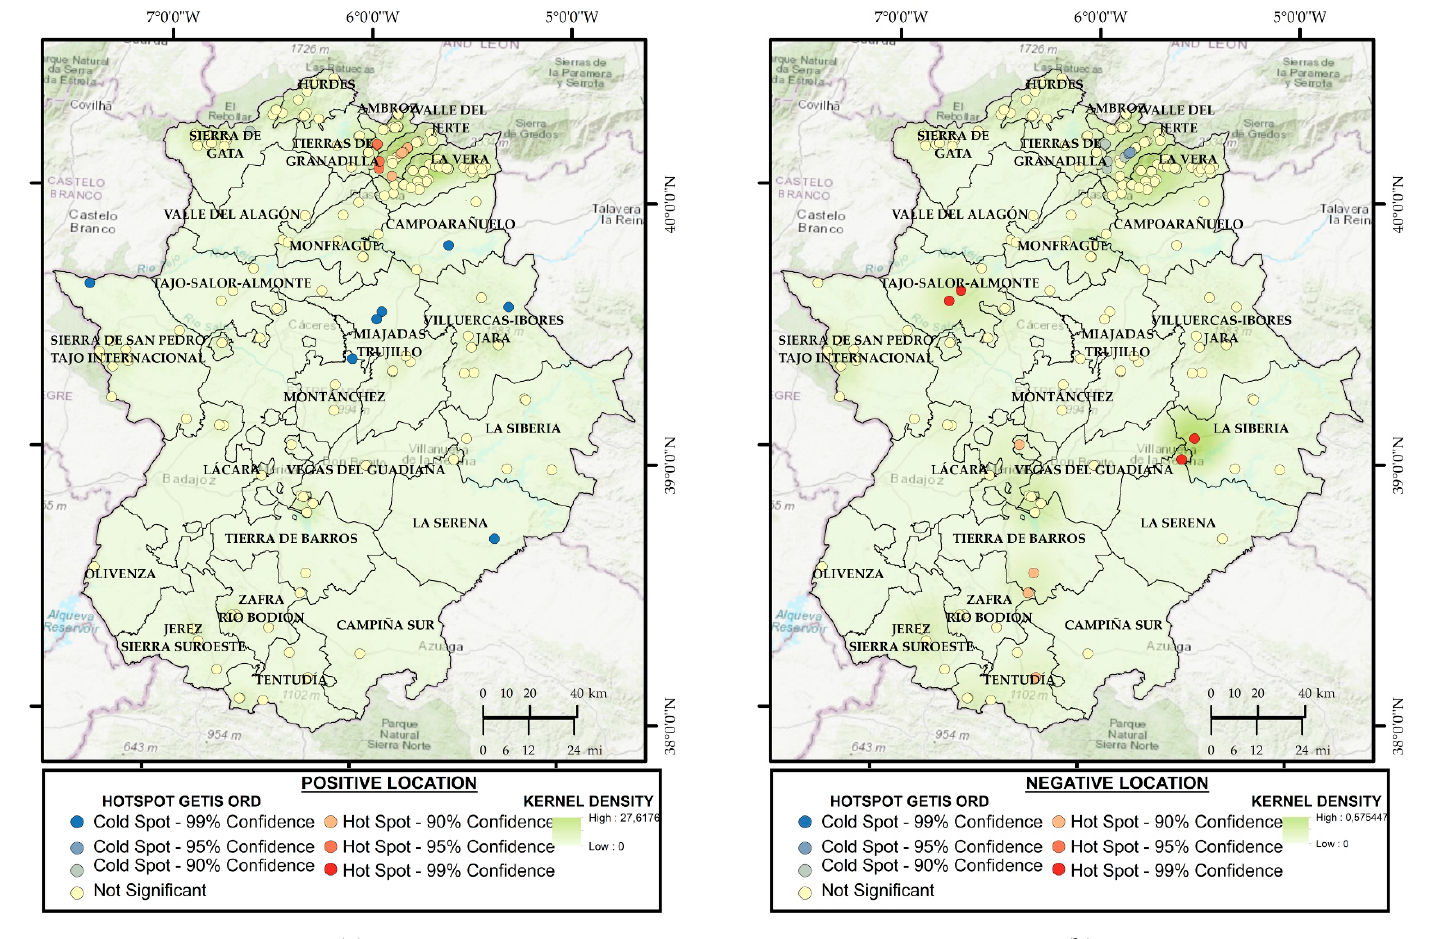
Figure 9. Gi* Getis Ord Location Positive ( a ) and Negative ( b ) mentions.